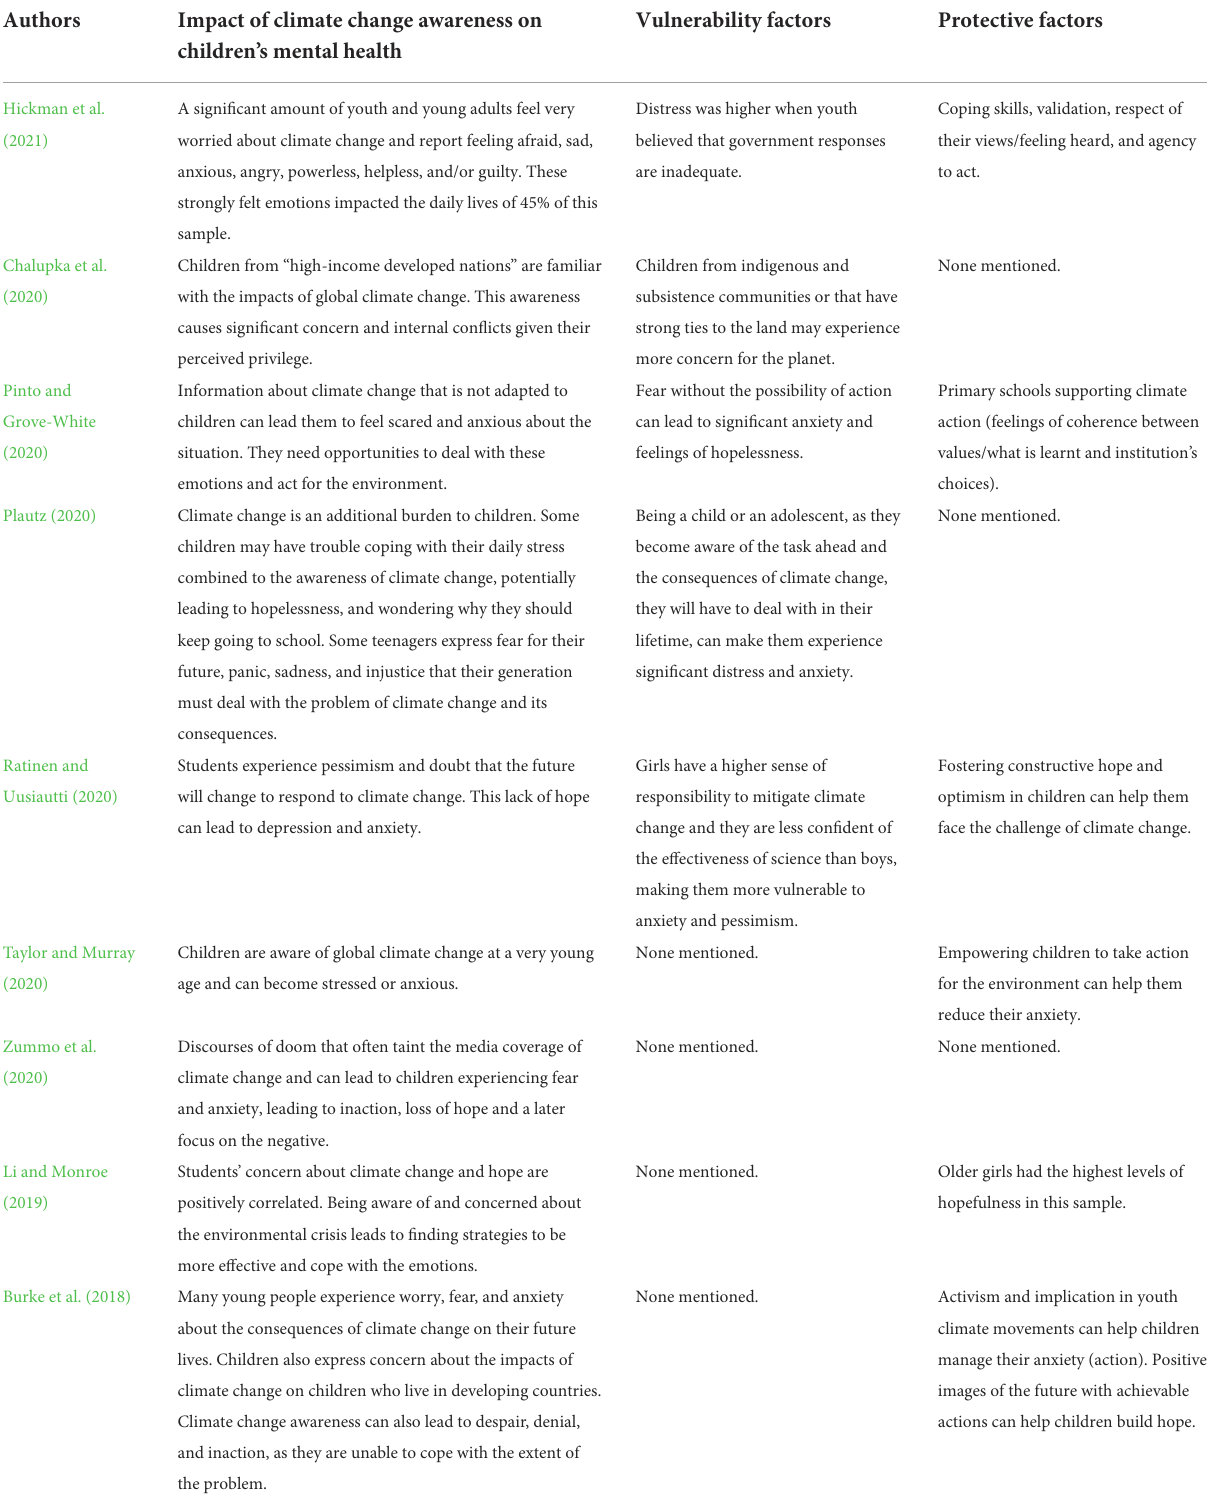
TABLE 4 Charted scoping review data from all 18 papers, arranged chronologically and by